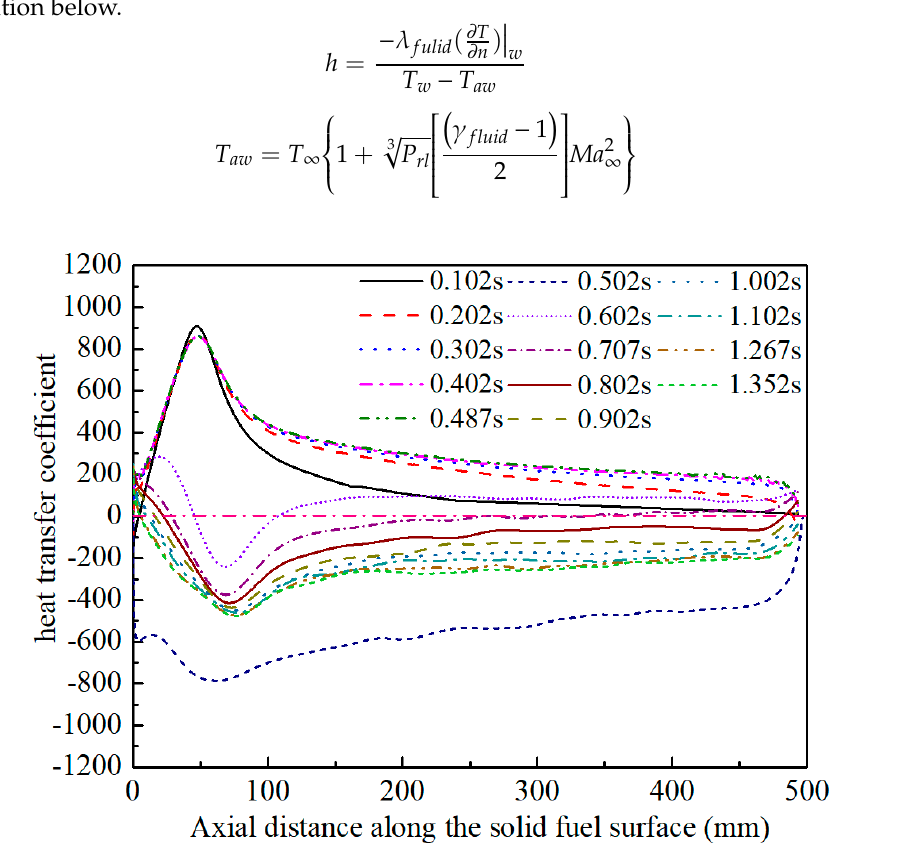
Figure 23. The heat transfer coefficient along high-density Polyethylene (HDPE) surface of different time for swirl flow.